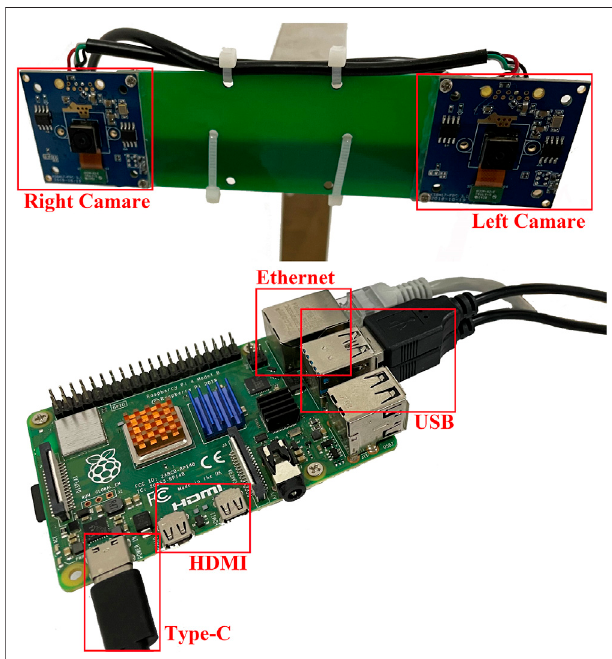
FIGURE3| |Physicalimageoftheexperimentalplatform.Theoneonthe left was embedded computer Raspberry Pi 4B with USB ports, Ethernet port, HDMI interface and Type-C interface. On the right was the binocular camera with a bracket. The left and right cameras were distributed on it.